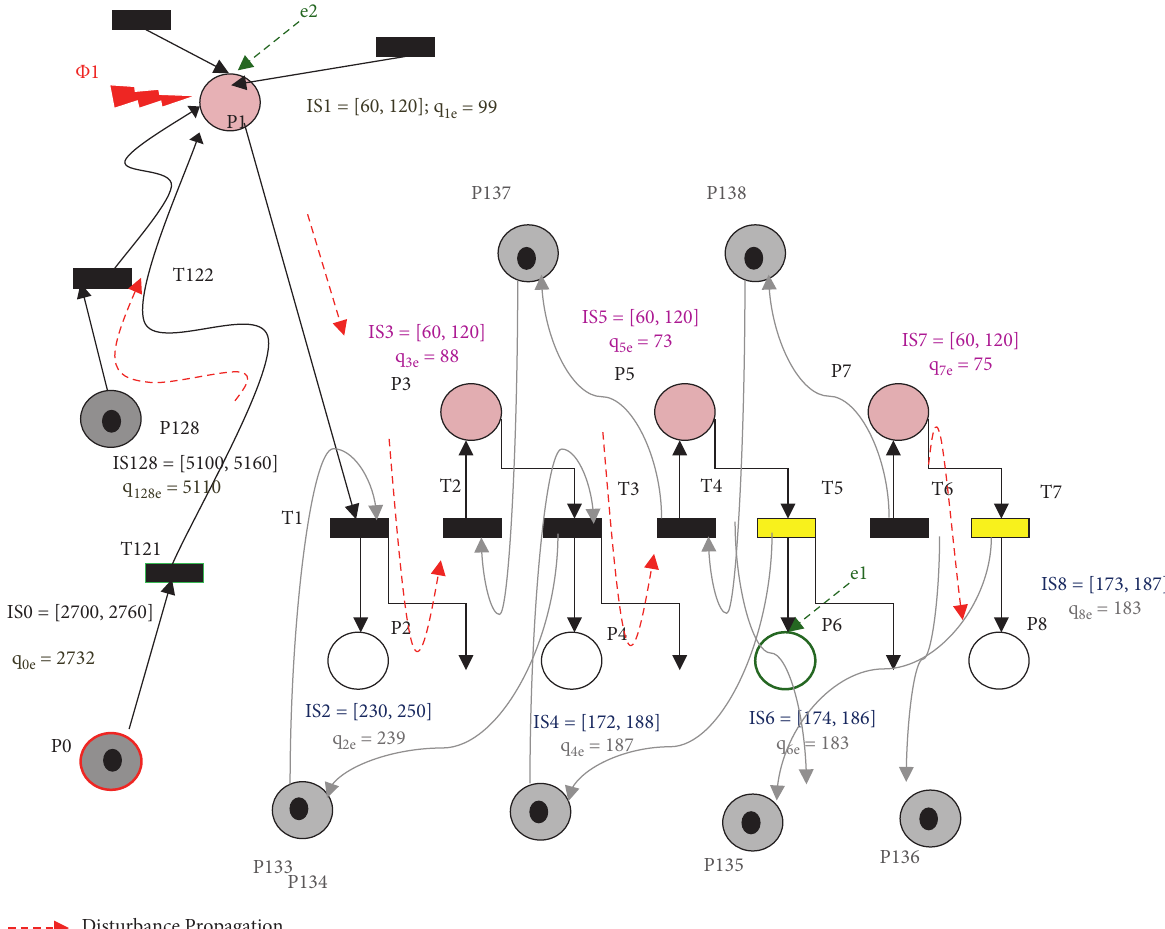
Figure 13: Example of disturbance propagation on the railway network between Mahdia and Faculty station.